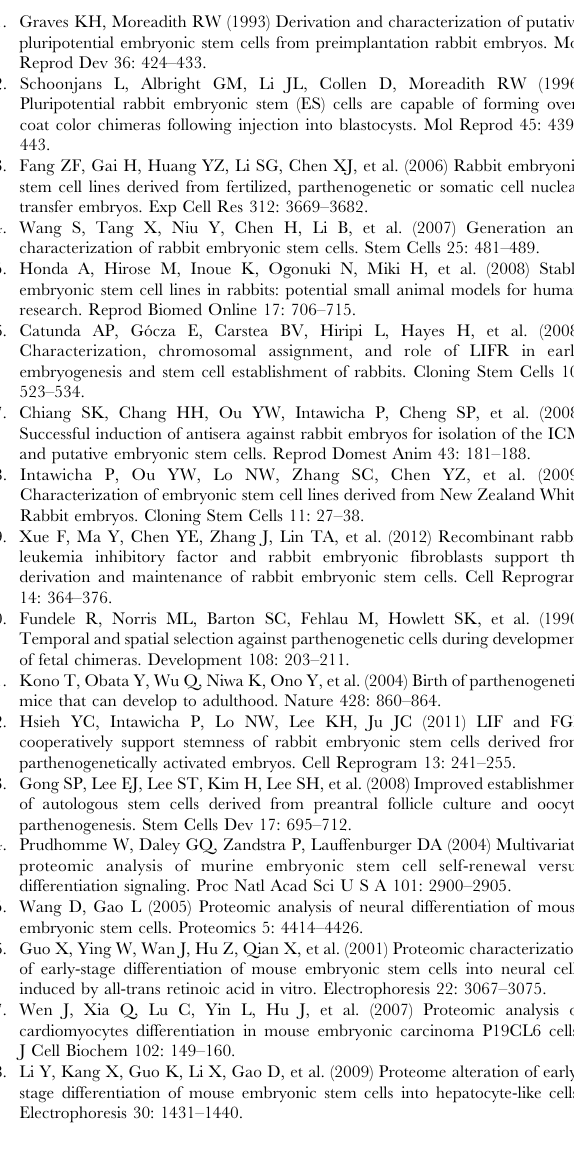
Table S1 Protein identities of the differentially expressed proteins in fibroblast, f-rES and p-rES cells. & Spot numbers